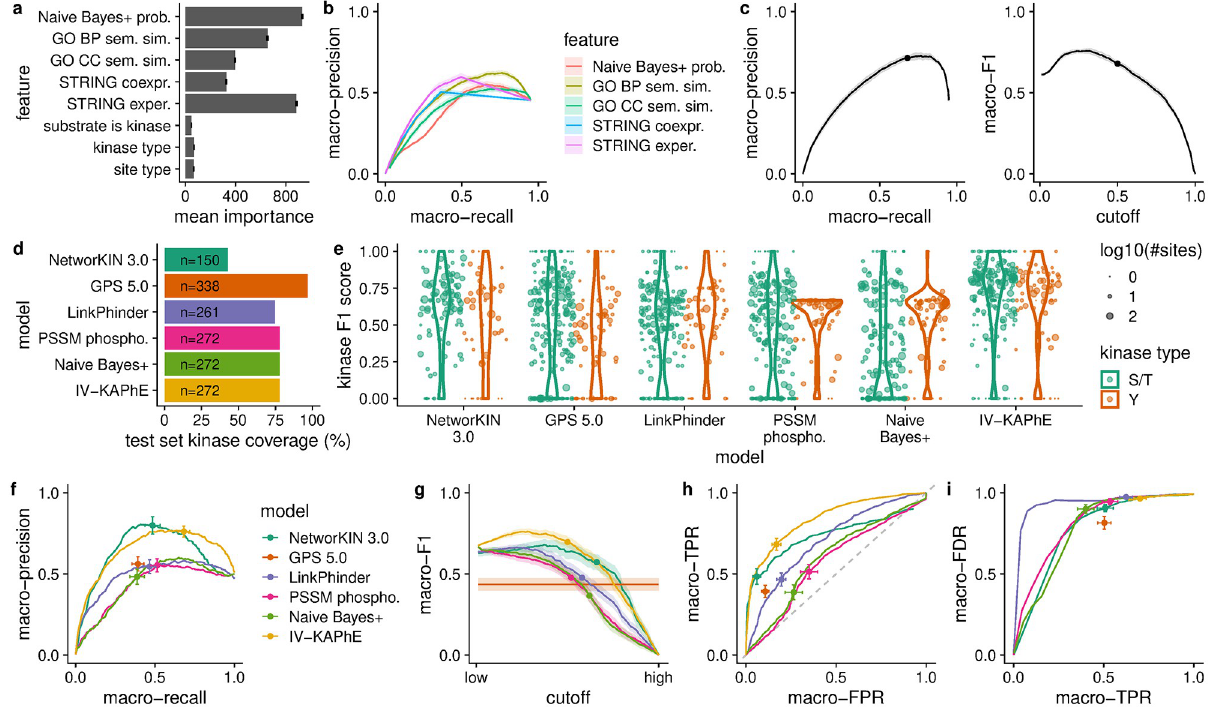
Fig 4. IV-KAPhE performs well in cross-validation and significantly outperforms previously published methods on anexternal validation set. a) Na ï ve Bayes+ posterior probability, GO BP semantic similarity, and STRING experimental score had the greatest importance when training the Random Forest models. Error bars show standard error across cross-validation runs. b) Predictive performance of individual quantitative features, as assessed by average macro-precision and macro-recall across 10 folds of the training data, reveals GO BP semantic similarity and STRING experimental score as being the most predictive individual features. c) Cross-validation evaluated via macro-averaged precision, recall and F1 all reflect strong performance by IV-KAPhE. d) IV-KAPhE’s coverage of the external test data set is similar to LinkPhinder’s but is lower than that of GPS 5.0. e) Kinase- specific F1 scores reveal IV-KAPhE’s consistently strong performance across most kinases, with similar performance for S/T and Y kinases, compared to other methods. f) IV-KAPhE outperforms the simpler PSSM-based and Na ï ve Bayes+ methods as well as other previously published methods in kinase-substrate assignment of an external validation set. Points indicate the scores for simple assignments (GPS) or the scores at nominal cutoffs for quantitative predictions (cutoffs—IV-KAPhE: 0.5, PSSM: 0.75, Na ï ve Bayes+: 0.5, LinkPhinder: 0.672 [27], NetworKIN 3.0: 1.0 [40]). Error bars show the 95% confidence intervals at these points. g) IV-KAPhE has a higher macro-averaged F1 score than the other methods. Points and color assignments are as in (e). Bands indicate the 95% confidence interval. h) IV-KAPhE similarly outperforms the other methods in Receiver Operating Characteristic (ROC) curve analysis for this balanced test set. Points and color assignments are as in (e). Error bars show 95% confidence intervals. i) Focusing on multi-label assignment for sites in the test set with known kinases, the macro-averaged false discovery rate (FDR; i.e. rate of novel assignments) dominates the average true positive rate (TPR). The curves are similar for most methods. At its nominal cutoff, IV-KAPhE has the second-highest FDR, but it is matched by the highest